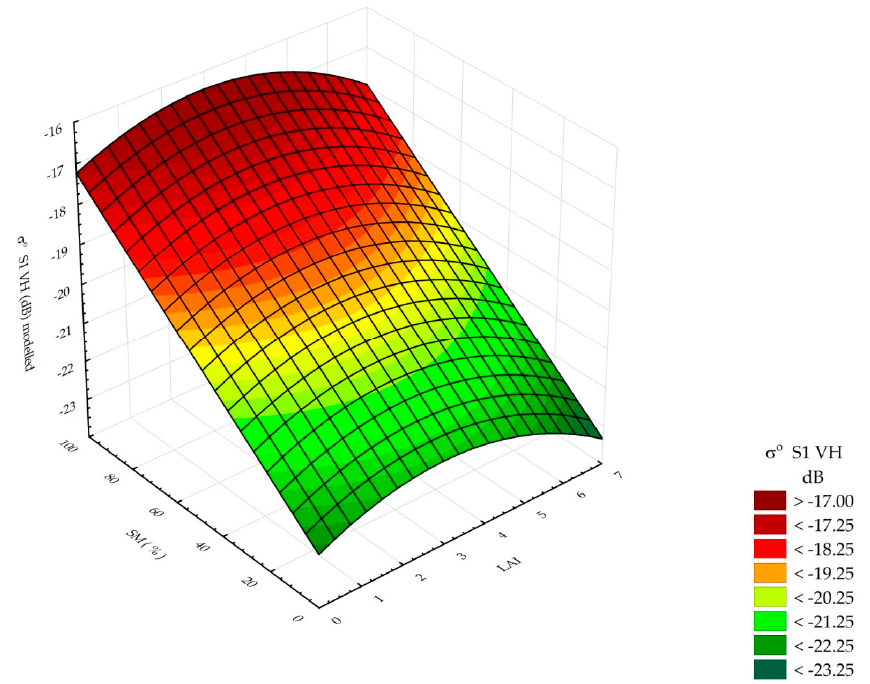
Figure 10 presents the relationship between observed and modelled σ ° VH (dB) for SM <40, where R 2 = 0.6, p < 0.05, number of observations—52, RMSE = 0.73 dB, MBE = 0.1 dB. When LAI is Figure 9. 3D-area plot for Equation (2). Figure 9. 3D-area plot for Equation (2). constant, the partial correlation for SM explaining σ ° VH variation gave R equal to 0.61, and R was equal to 0.48 for LAI explaining σ ° VH variation when SM is constant.